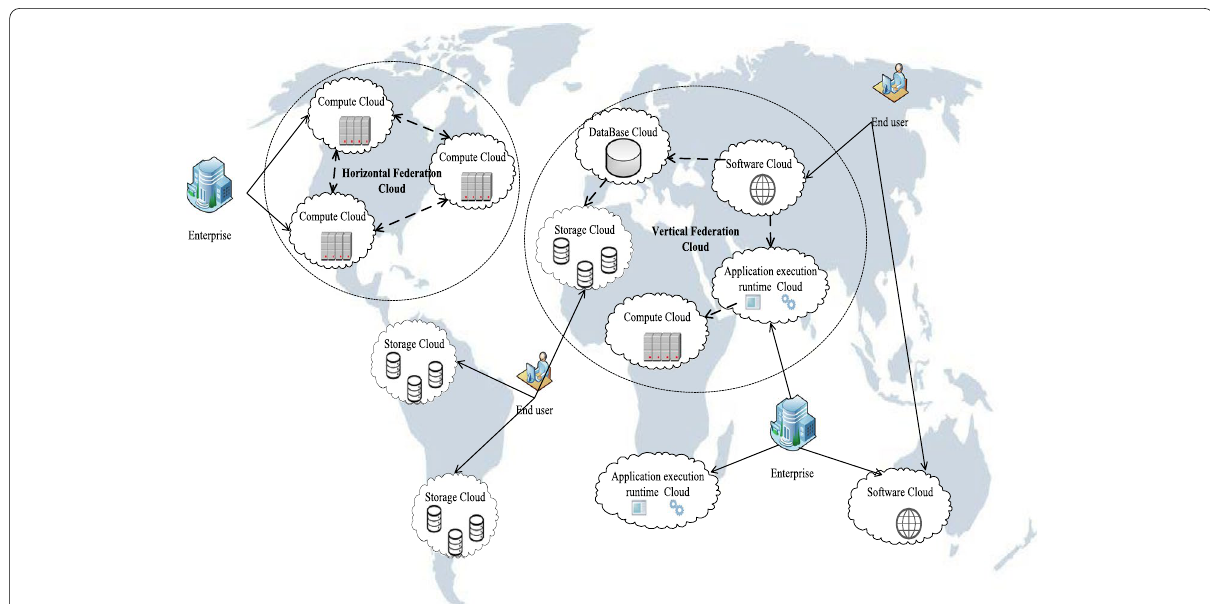
Fig. 2 Intercloud